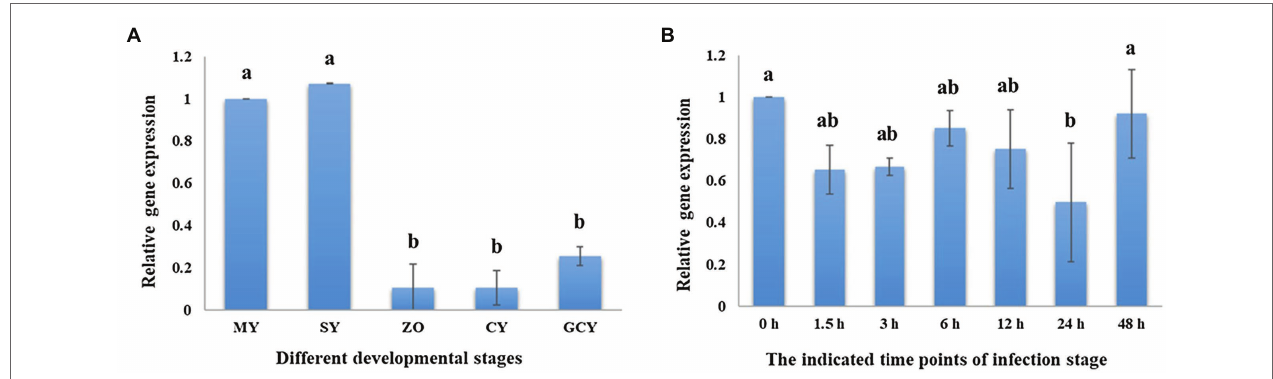
FIGURE 2 | PsPTL gene transcription profile. (A) Sample tissues of P. sojae P6497 included mycelia (MY), hyphae with sporangia (SP), zoospores (ZO), cystospores (CY), and germinated cystospores (GCY), and the transcript levels of other samples are shown relative to MY, which was assigned a value of 1.0. (B) The samples of infection stages were collected for 0, 1.5, 3, 6, 12, 24, and 48 h after infection of susceptible soybean cultivar Japan blue, and the transcript levels other samples are shown relative to the sample of 0 h, which was assigned a value of 1.0. Columns indicate means, and bars signify SD. Different letters above the columns indicate statistically significant differences ( p < 0.05).